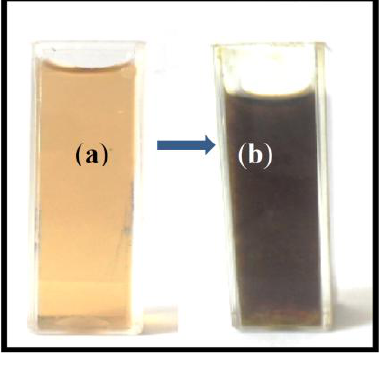
Figure1. The aqueous extract of S. muticum ( a ) before; and ( b ) after synthesis of Ag-NPs.